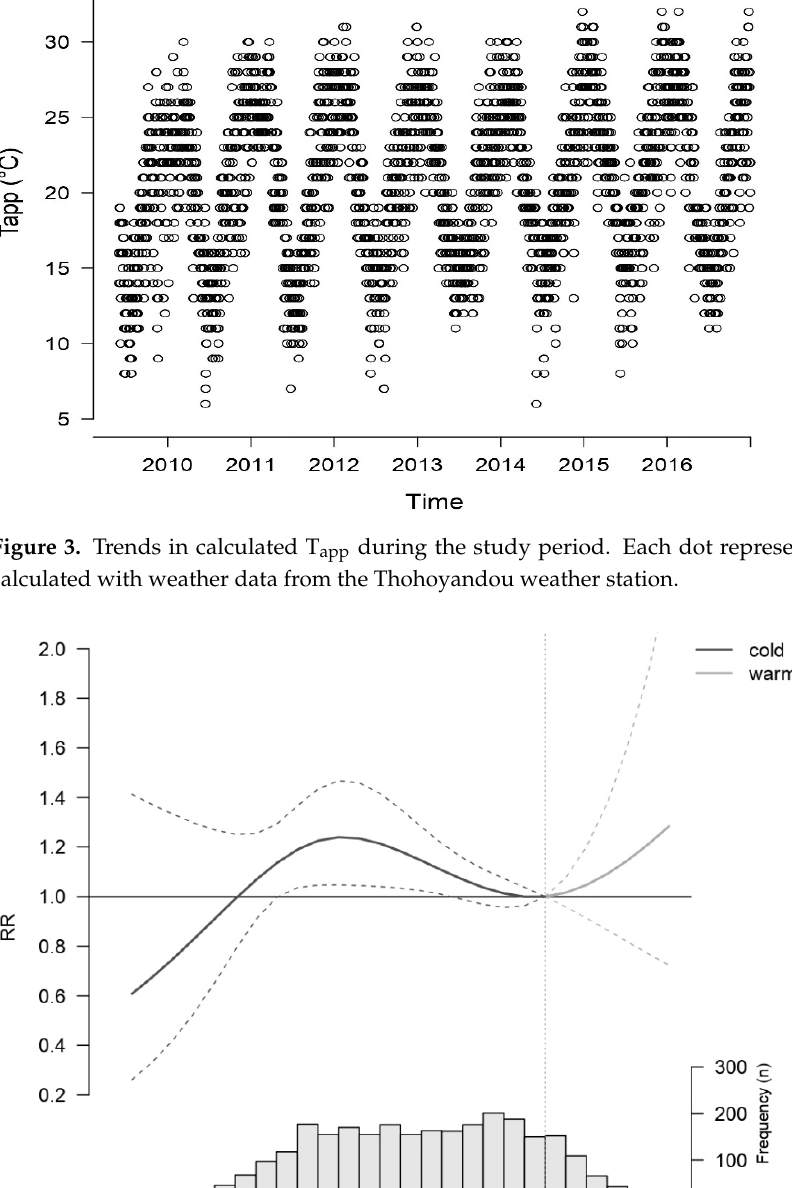
Figure 2. ( a ) The distribution of daily total (N = 37,090) and CVD (N = 3124) hospital admission counts during the study period, and ( b ) the distribution of total and CVD hospital admission counts in relation to T app .